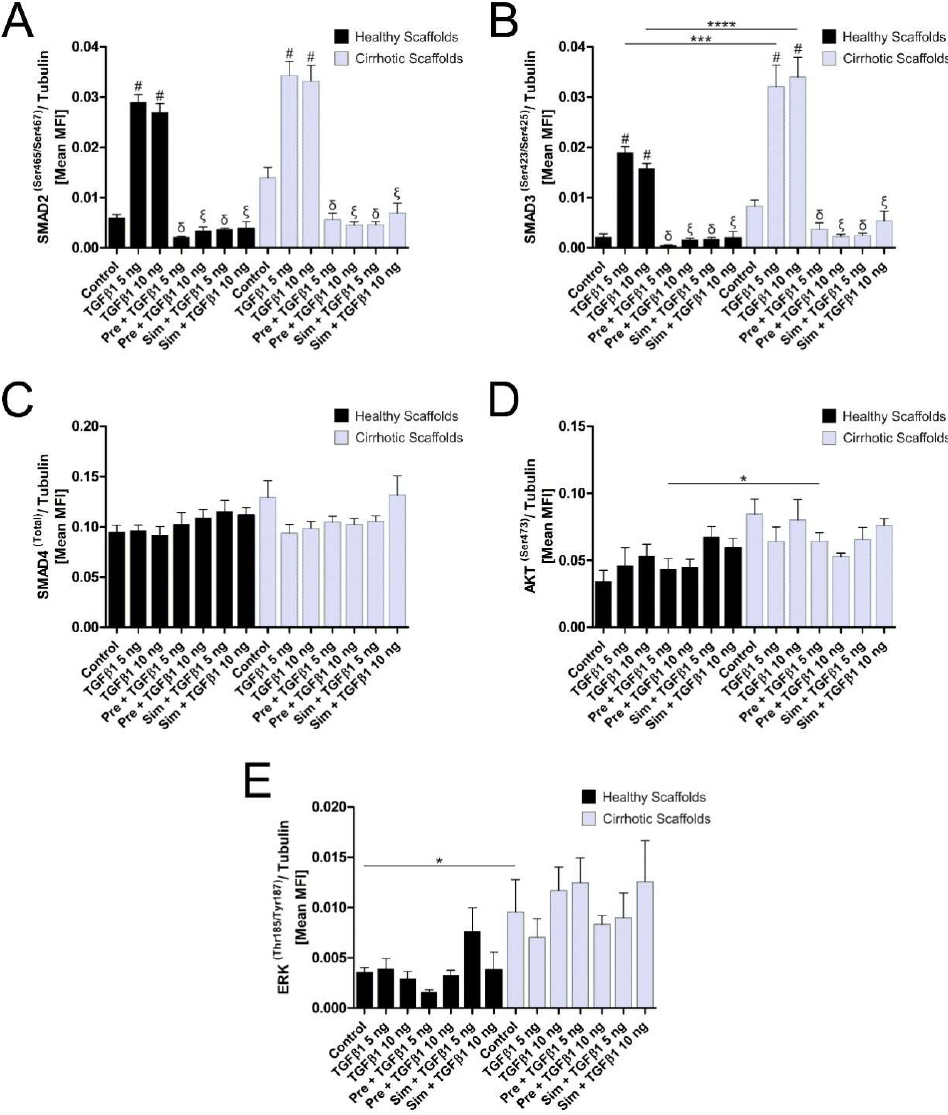
Figure 5. A specific ECM composition dictates TGFβ1-induced p-Smad2 and p-Smad3